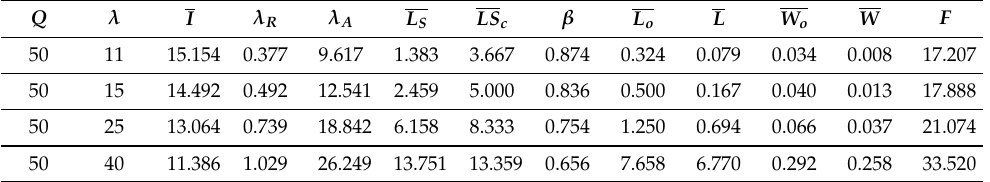
Table 5. The effect of λ on performance measures at Q =